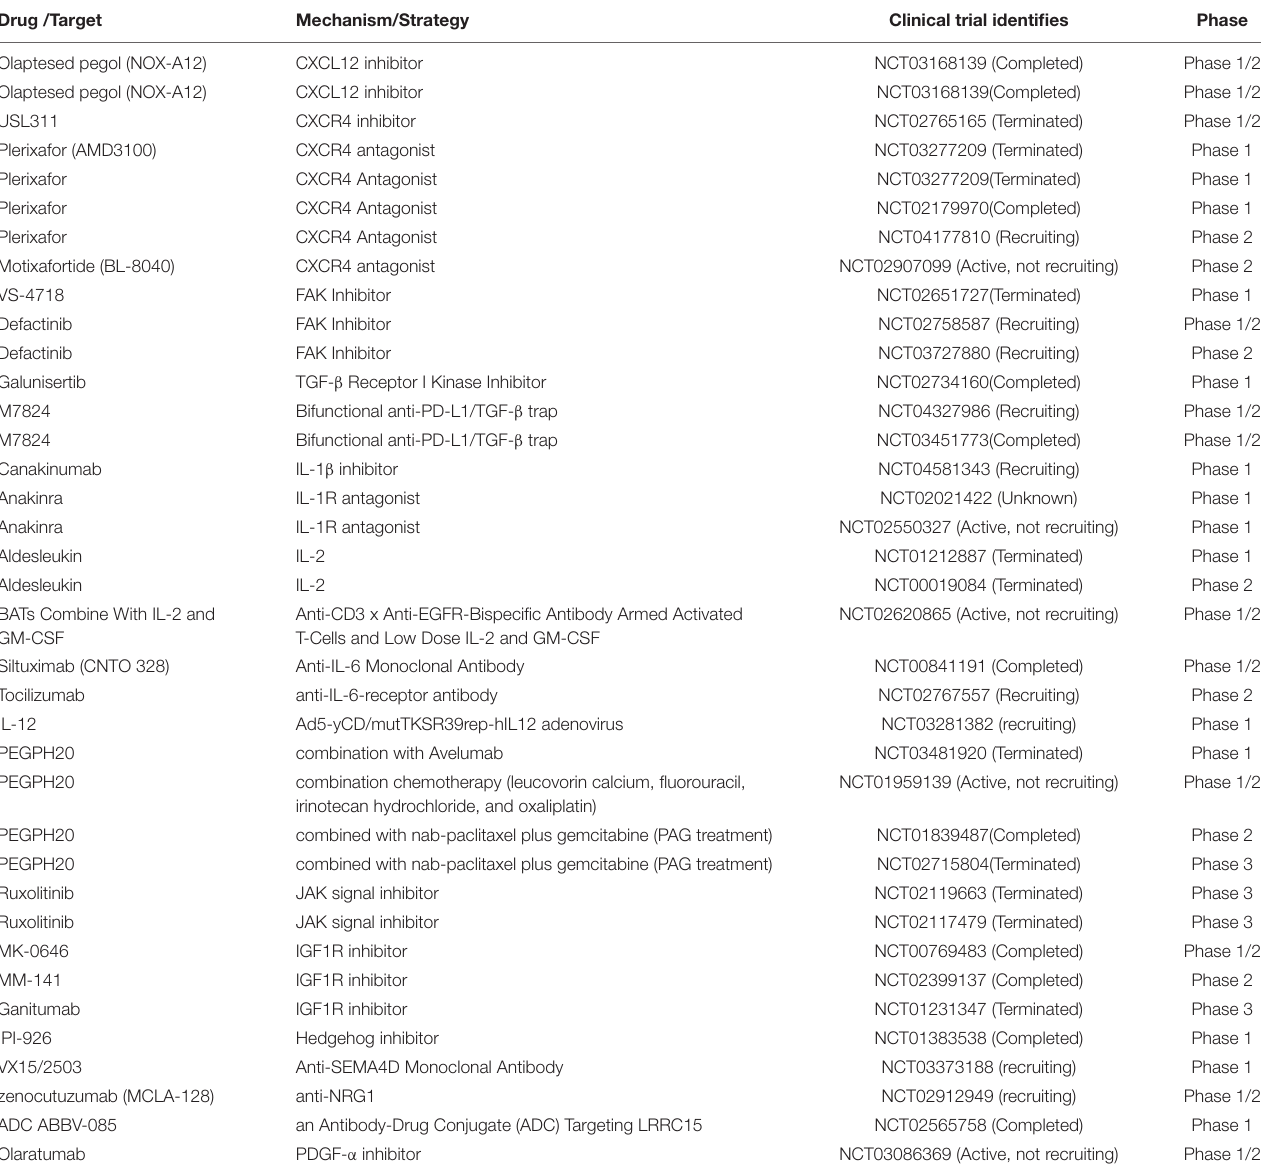
TABLE 1 | Clinical trials targeting/relating the CAF in